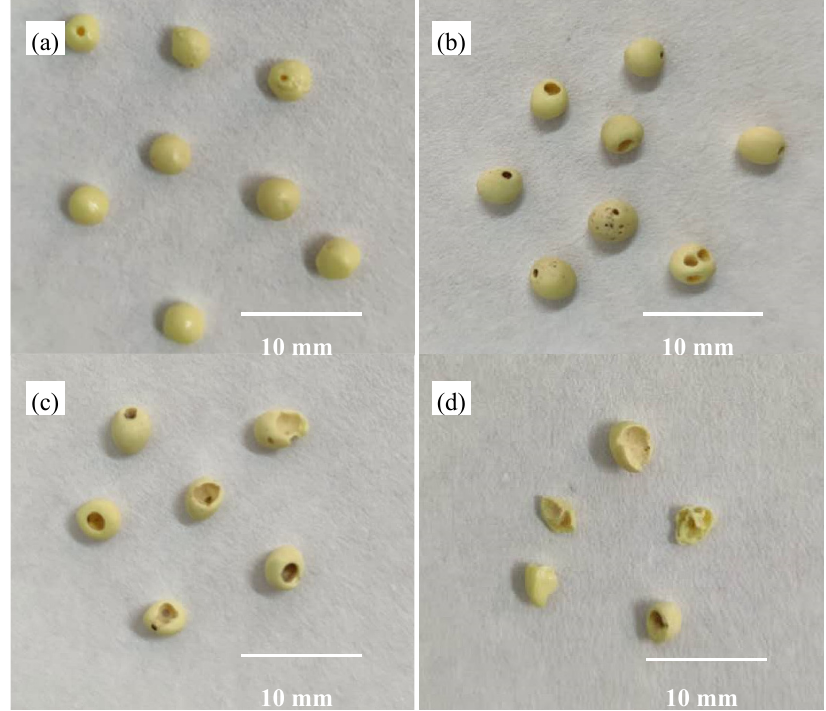
Figure 3. Photographs of fresh sulfur prill-3 ( a ) and the recovered sulfur prill-3 after bioleaching batch I ( b ), II ( c ) and III ( d ).